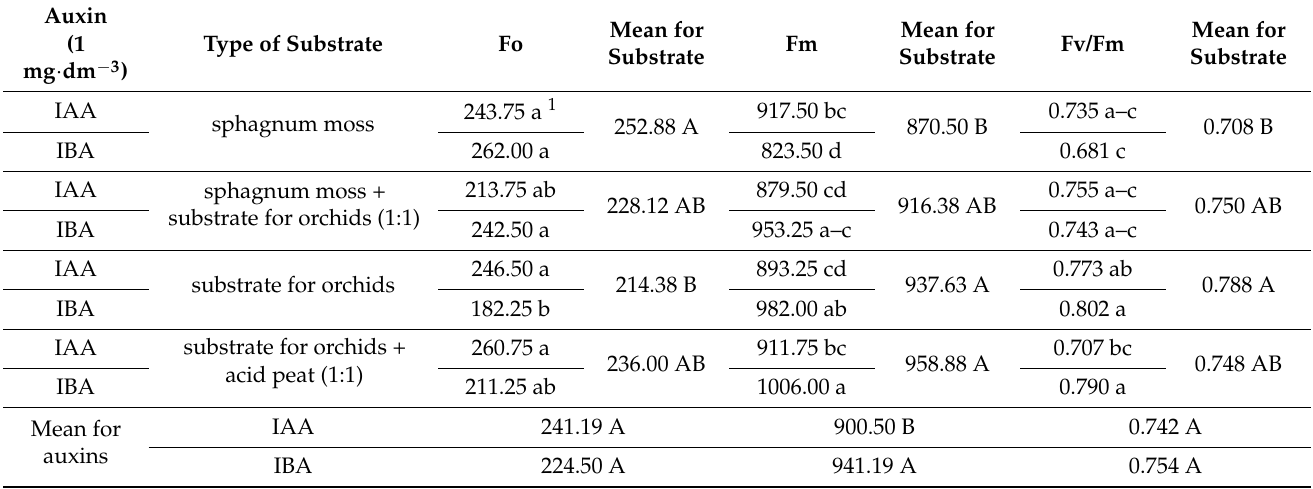
Table 6. A subsequent effect of IAA or IBA and substrate type on minimal fluorescence (Fo), maximal fluorescence (Fm) and maximal quantum efficiency of PS II (Fv/Fm) in leaves of Paphiopedilum insigne during acclimatization.